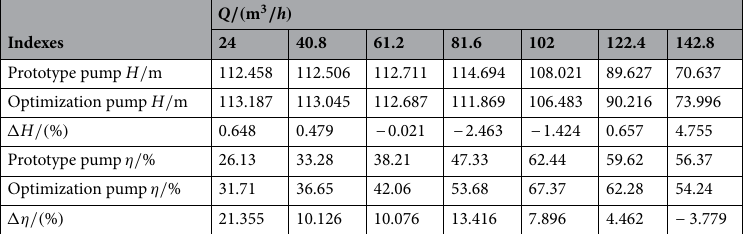
Table 7. Test results of each